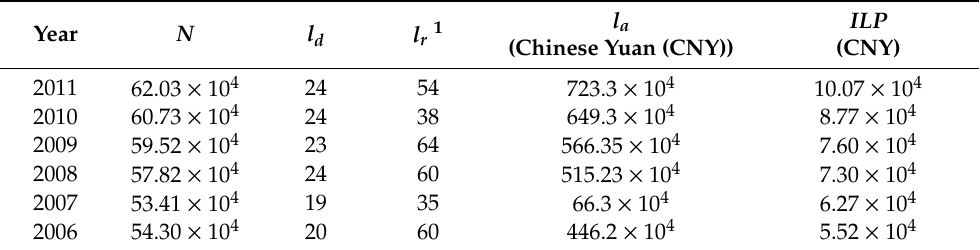
Table 2. Statistics on boiler-related accidents and industrial labor productivity ( ILP) in China from 2006 to